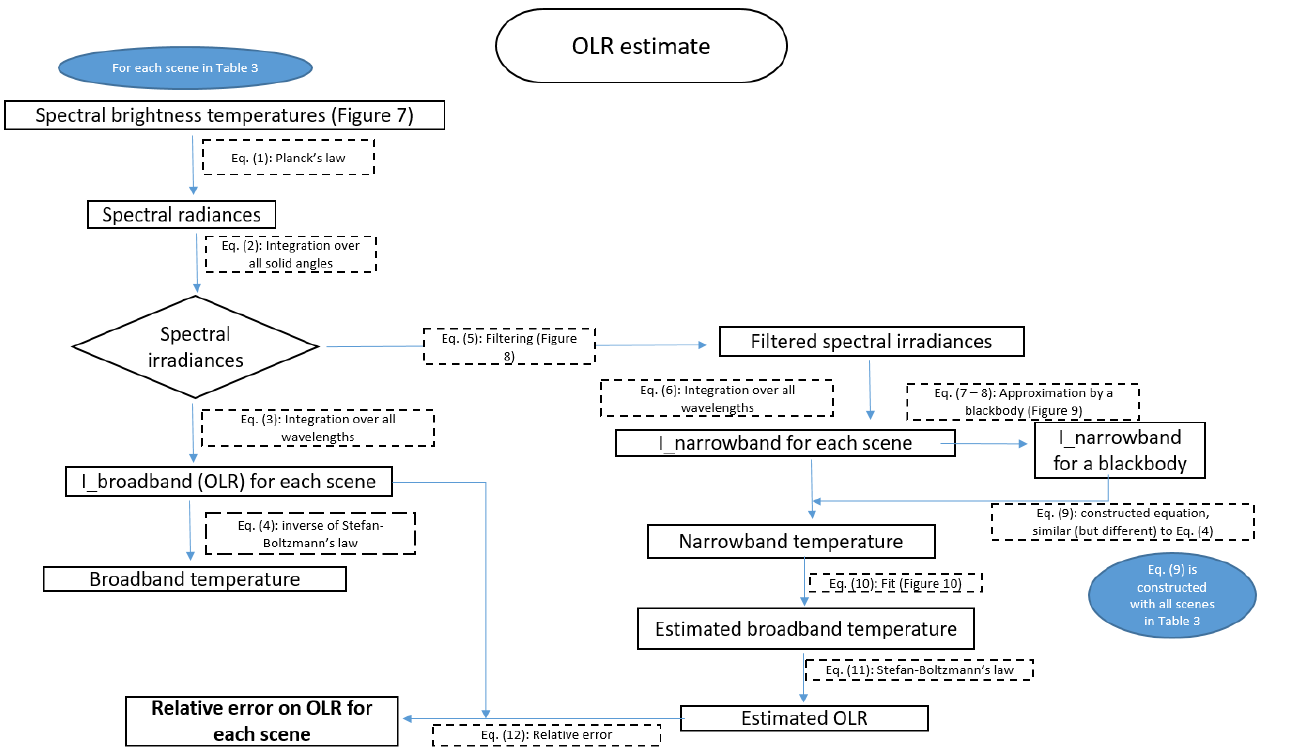
Figure 7. Flowchart summarizing the approach to estimate the Outgoing Longwave